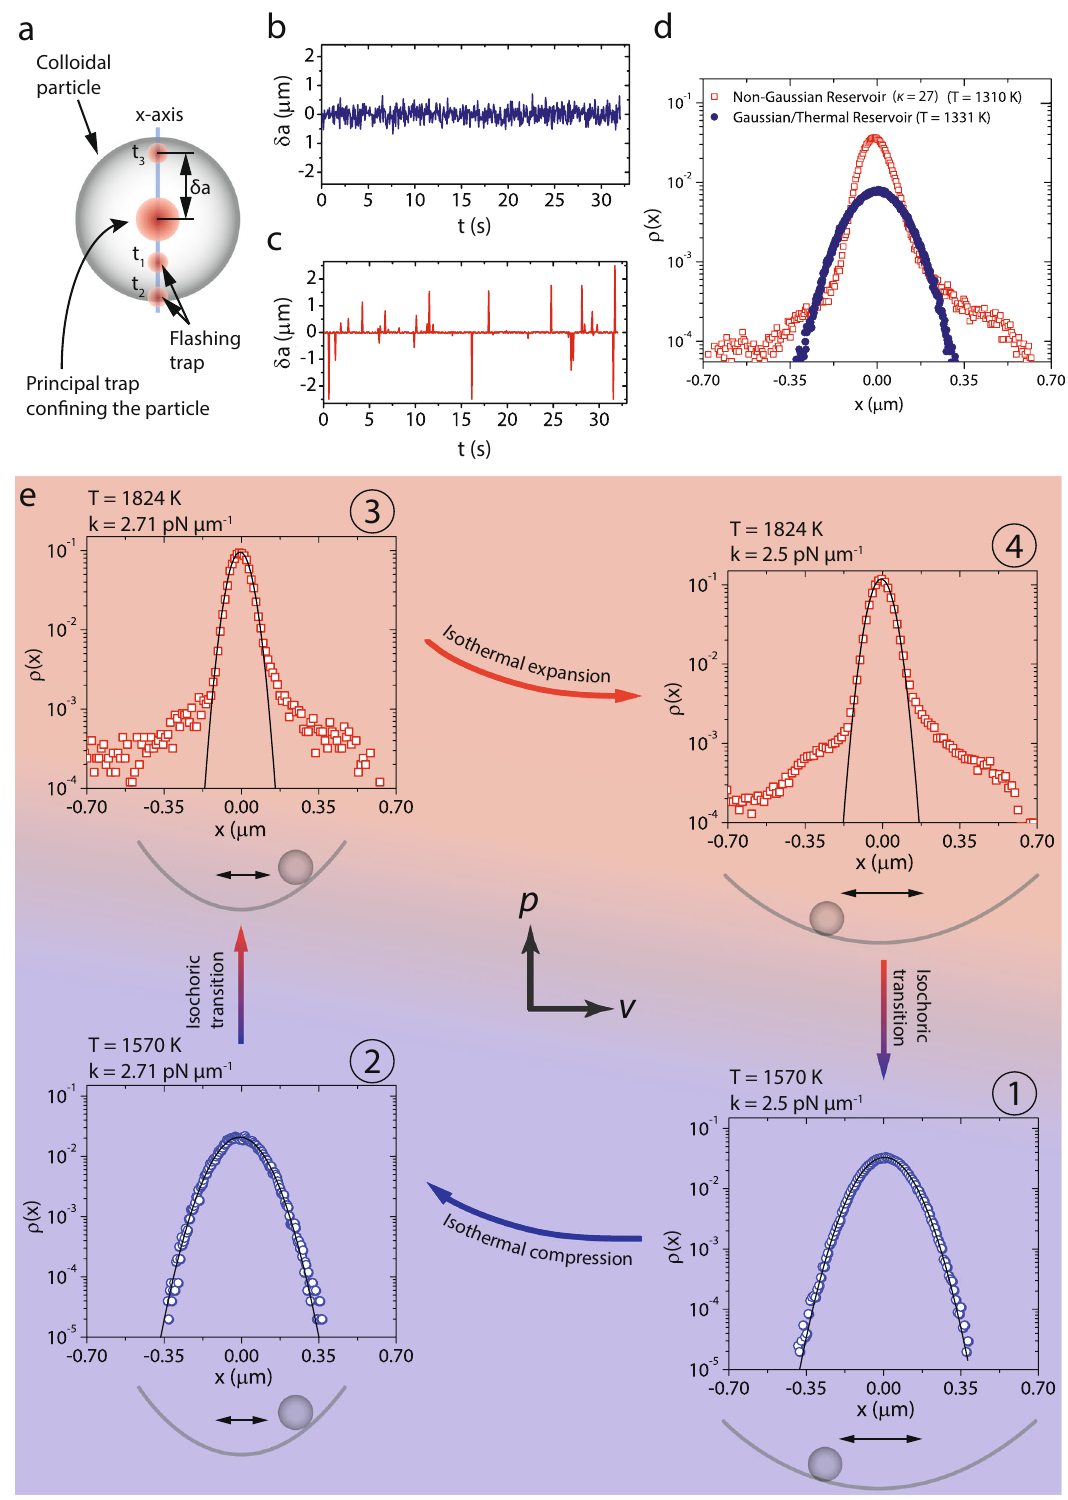
Fig. 1 Experimental realization of a non-Gaussian Stirling heat engine. a The big red spot represents the primary optical trap and the small red spots represent the secondary fl ashing optical trap at different time instances t 1 – t 3 . b , c The distance δ a ( t ) from the primary trap at which the secondary trap was fl ashed as a function of t for engineering a Gaussian and a non-Gaussian reservoir, respectively. d The probability distribution of particle displacements, ρ ( x ), for the engineered Gaussian/thermal (solid blue circles) and the non-Gaussian reservoir with κ = 27 (red hollow squares) for a nearly identical T eff . ¼ 1824 K and a cold Gaussian reservoir with T C ¼ 1570 K. The trap e A quintessential Stirling cycle between a hot non-Gaussian ( κ = 20) bath at T H eff eff stiffness k is varied linearly in the expansion/compression steps. Having a fi xed primary trap and a second fl ashing optical trap, as opposed to just the latter, prevented the trapped particle from escaping the trap and allowed for long experiments. ρ ( x ) of the particle measured at the four-state points (at equilibrium) labeled ① – ④ is also shown. The black lines are Gaussian fi